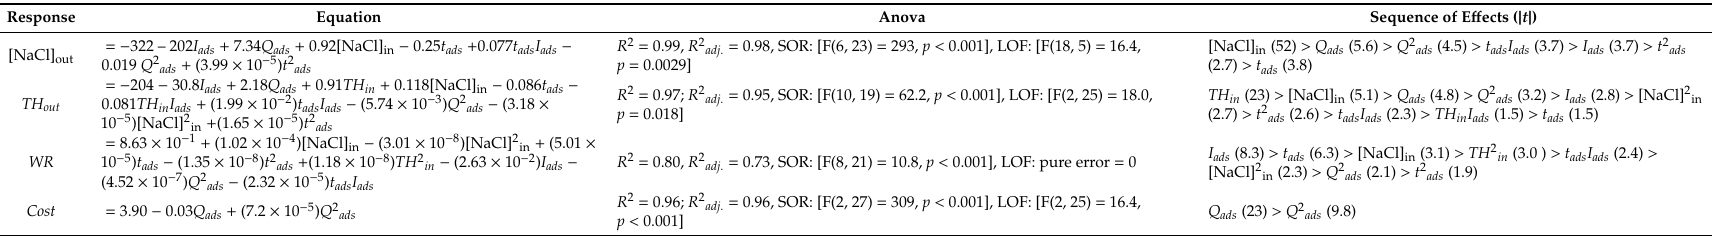
Table 3. Reduced regression equations ( α = 0.05) resulting multivariate regression on MCDI test data. Statistics include R 2 , adjusted R 2 , Significance of regression (SOR), lack of fit test (LOF) [29] and sequence of standardized e ff ects ( | t | ), units as in Table